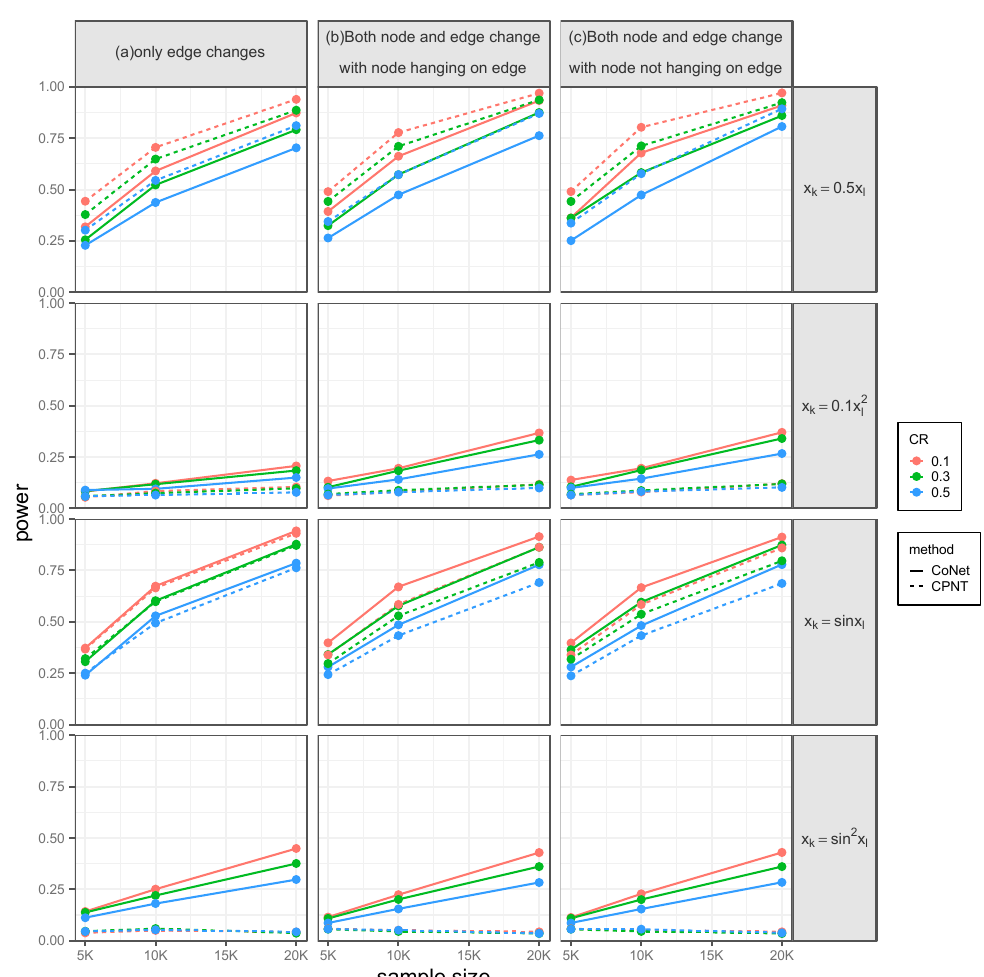
Figure 3. The power for testing the effect of the edge on the survival phenotype under pre-specified effecting edge settings, with the SNP effect obtained from the DPR model. Simulations were con- ducted with four different between-node correlation patterns (the combination of sine and quadratic, sine, quadratic, and linear) and three different censoring rates (0.1, 0.3, and 0.5). ( a ) Only an edge has an effect. ( b ) Both node and edge have effects, with the effecting node hanging on the edge. ( c ) Both node and edge have effects, with the effecting node not hanging on the edge.